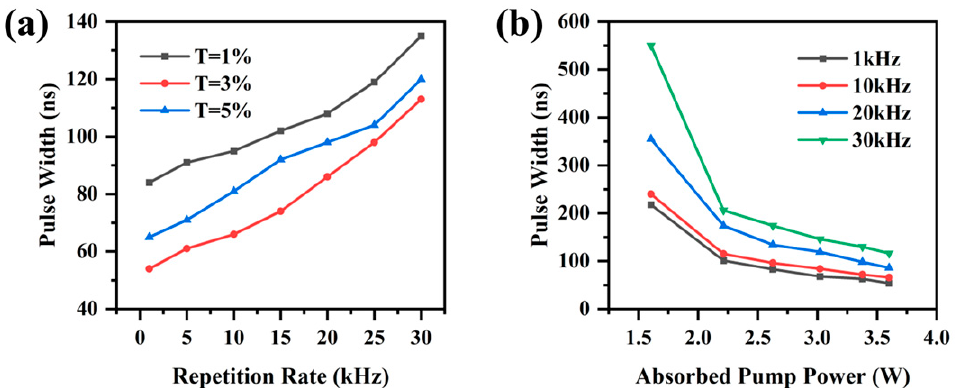
Figure 5. ( a ) Pulse widths versus repetition rates at the maximum absorbed pump power; ( b ) Variation of the shortest pulse widths with absorbed pump power at different repetition rates.